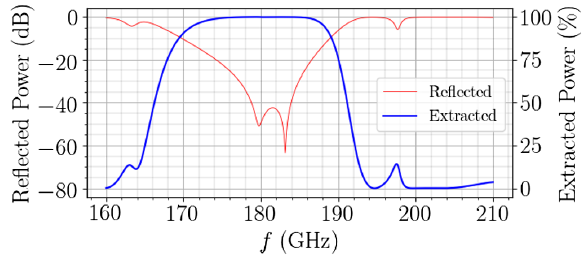
FIG. 7. Reflection and extraction of the TE 11 mode from the IOM in isolation. The extracted power is divided between the two rectangular waveguide outputs corresponding to the polarization of the incident TE 11